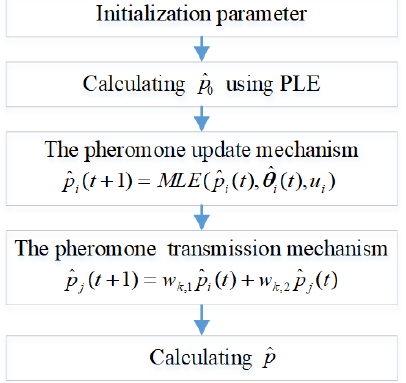
Figure 4. The flowchart of the proposed algorithm.